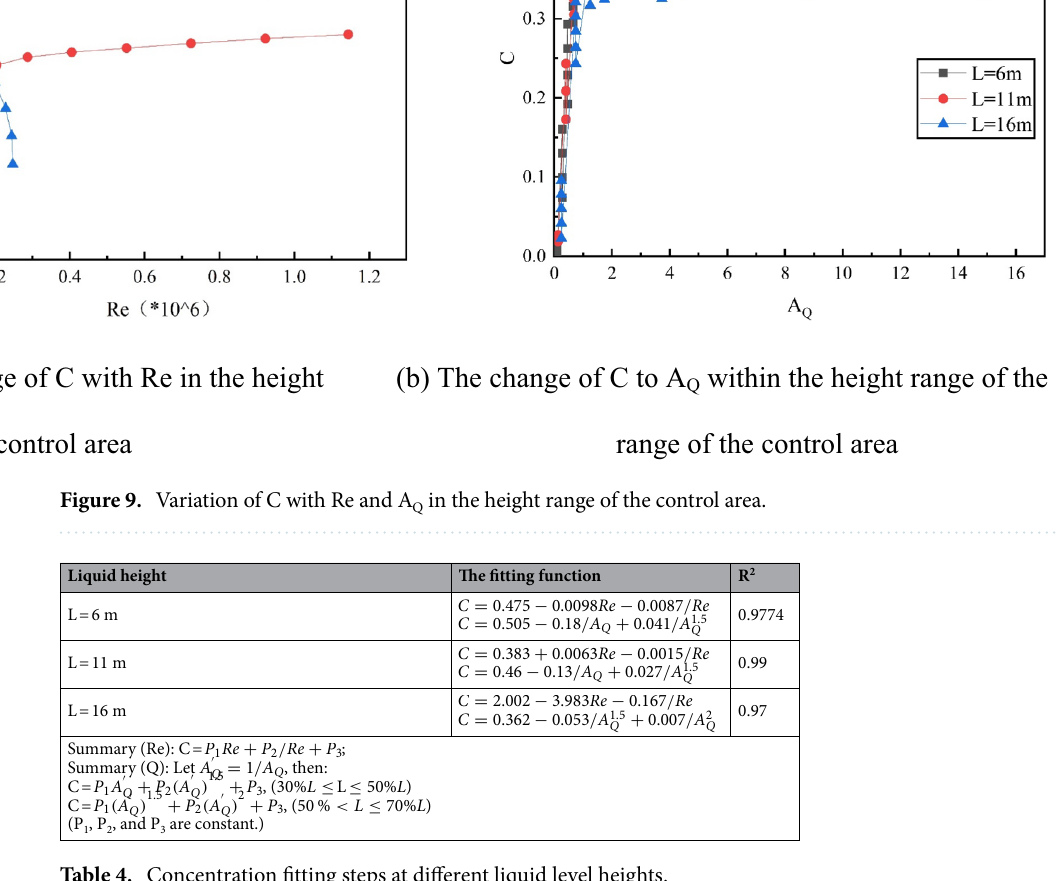
Table 4. Concentration fitting steps at different liquid level heights.